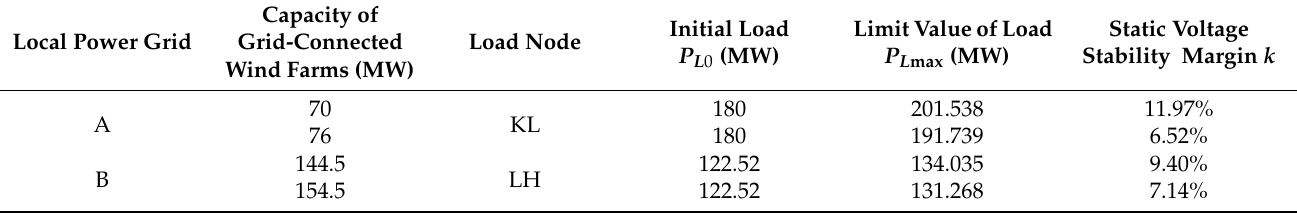
Table 1. Static voltage stability margins after the wind power